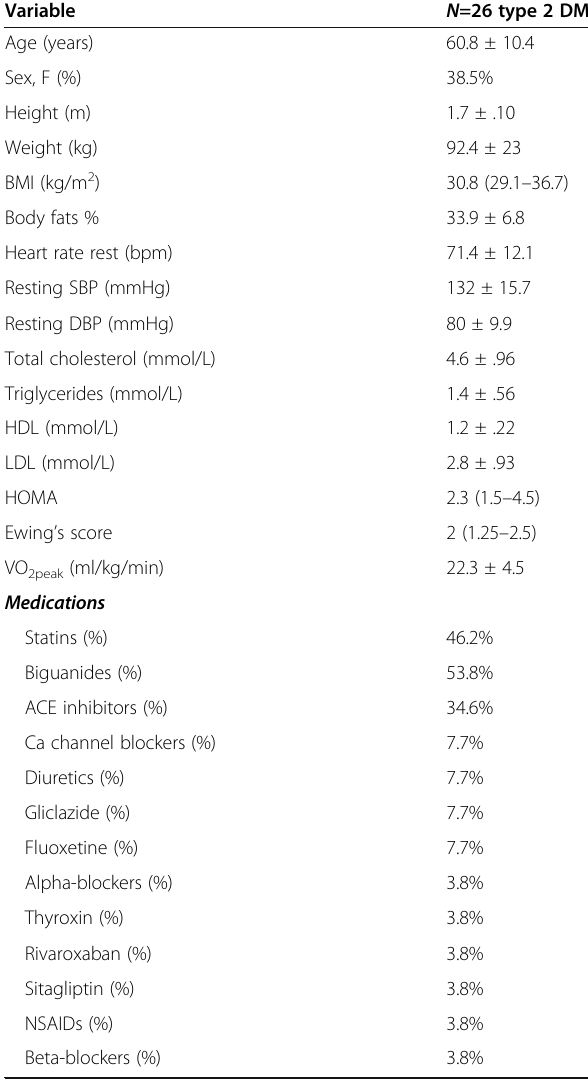
Table 2 Demographic characteristics and common CVD risk factors of the